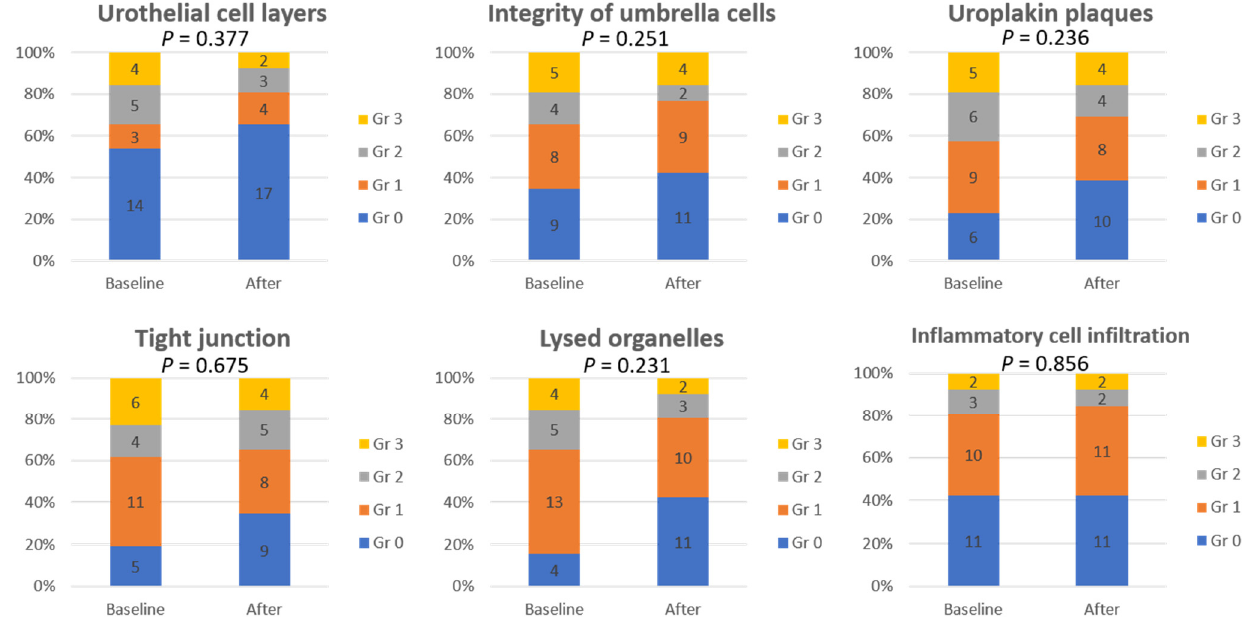
Figure 2. Comparison of urothelial ultrastructural defects in interstitial cystitis/bladder pain syndrome bladders at baseline and after the 4th platelet-rich plasma injection. Gr: grade of urothelial defects.